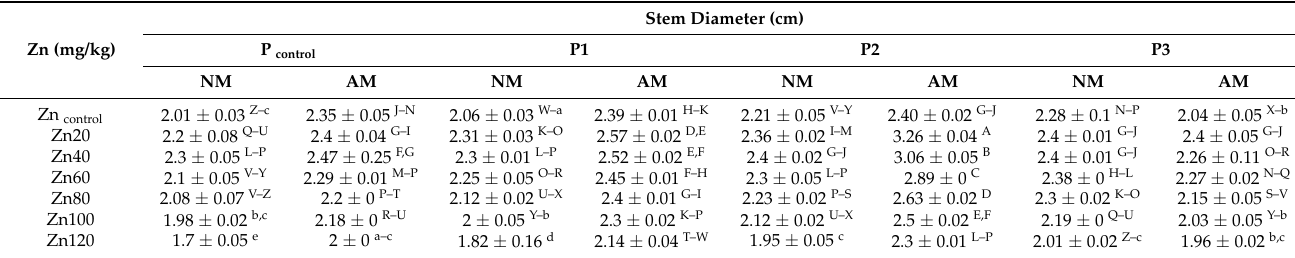
Table 4. Stem diameter (cm) of AMF inoculated (AM) and non-inoculated (NM) plants grown under various P (0 to full recommended dose) and Zn (0–120 mg Zn/kg soil) application rates.